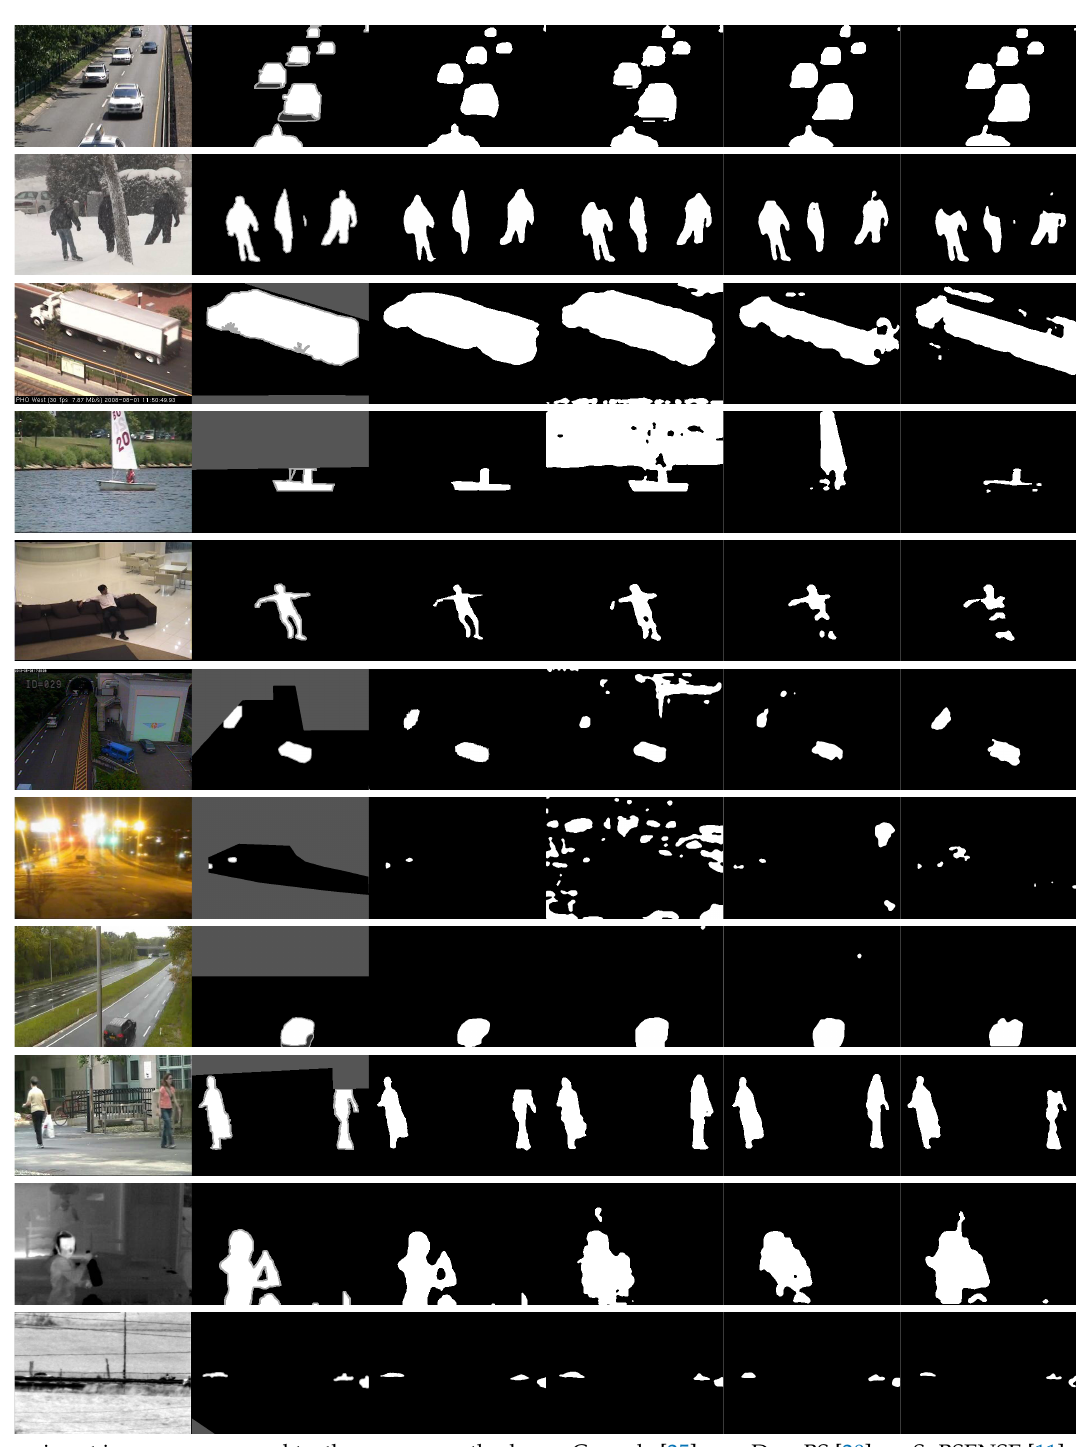
Figure 5. Results of CDnet 2014 dataset (From top to bottom: “baseline”, “badWeather”, “cameraJitter”, “dynamicBackground”, “intermittentObjectMotion”, “lowFramerate”, “nightVideo”, “PTZ”, “shadow”, “thermal”, and “turbulence”. The gray pixels in the ground truth indicate regions that are not